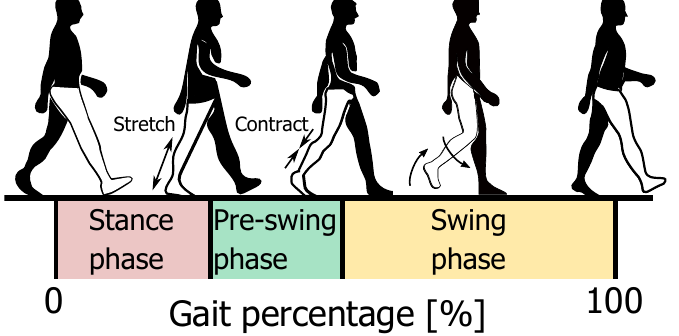
Figure 5. Gait phases in one cycle motion. A horizontal axis represents a gait percentage in the one cycle motion. The gait phases of a white color leg are classified in a stance phase, a pre-swing phase, and a swing phase, and an opposite side leg is also classified in the same